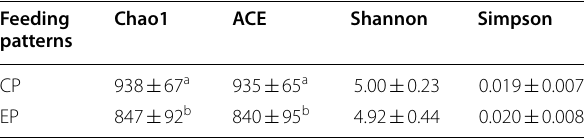
Table 1 Estimated OTU richness and diversity indices in CP and EP